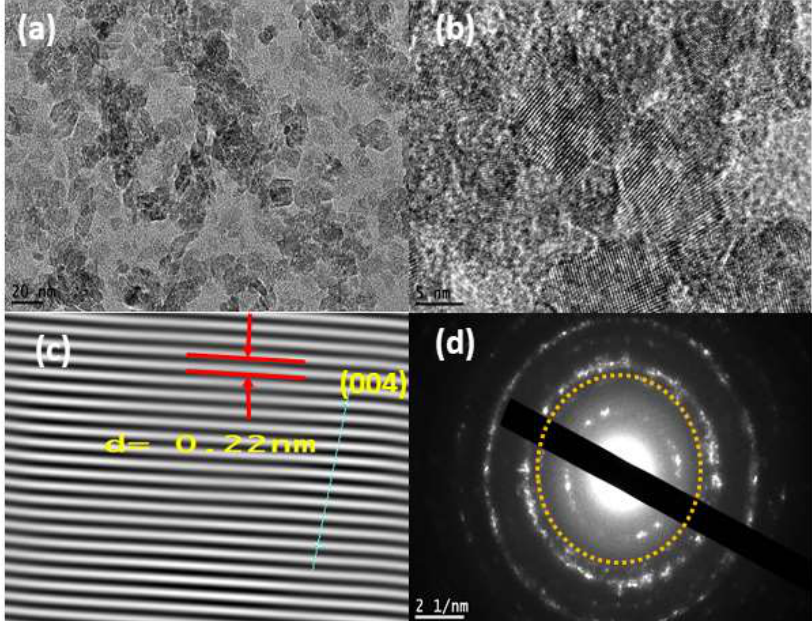
Figure 7. ( a , b ) TEM images, ( c ) HRTEM image, and ( d ) SAED pattern of the 5 nm Nb/TiO 2 nanoparticles.